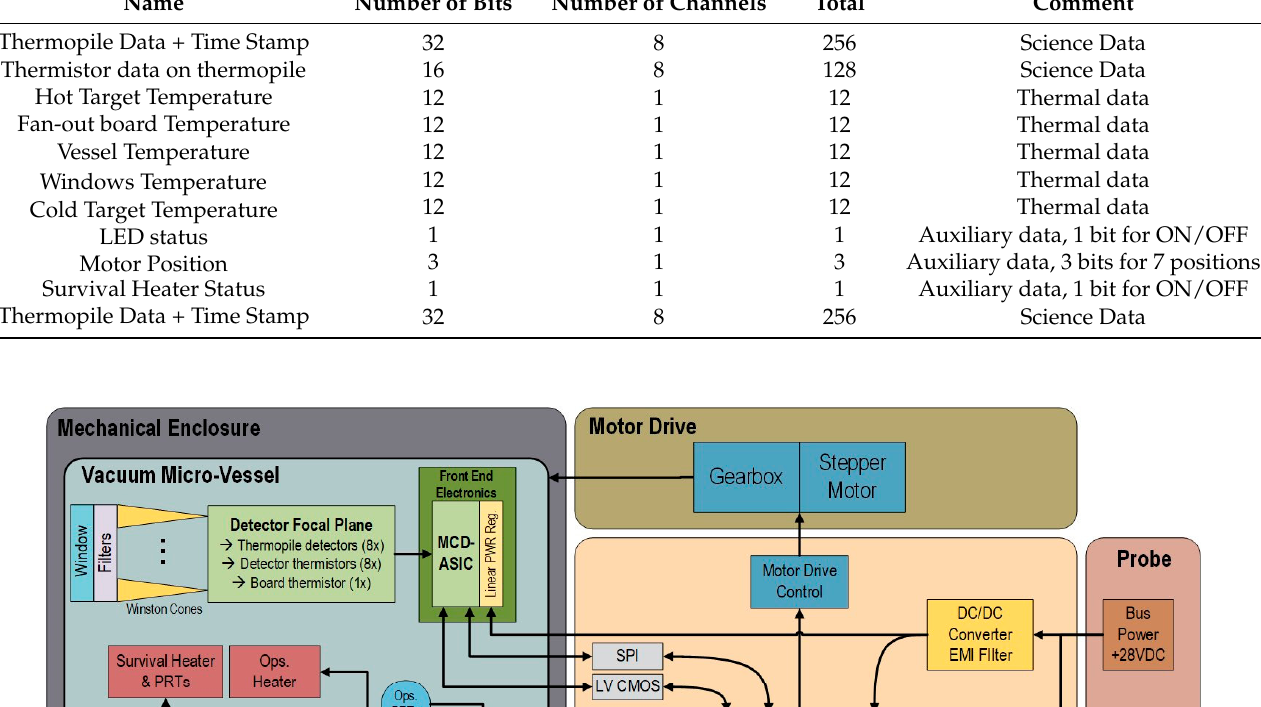
Figure 2. System block diagram. The CRC error check will run on the processor card shown in the main electronics box.